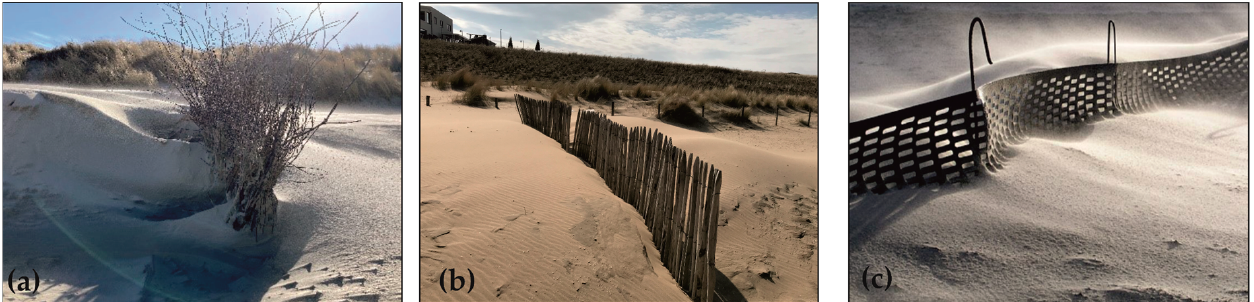
Figure 2. Examples of different design types of sand trapping fences: ( a ) brushwood, ( b ) vertical plank, ( c ) perforated plastic. Photograph in ( c ) is published with permission from Peter Tigges [42].